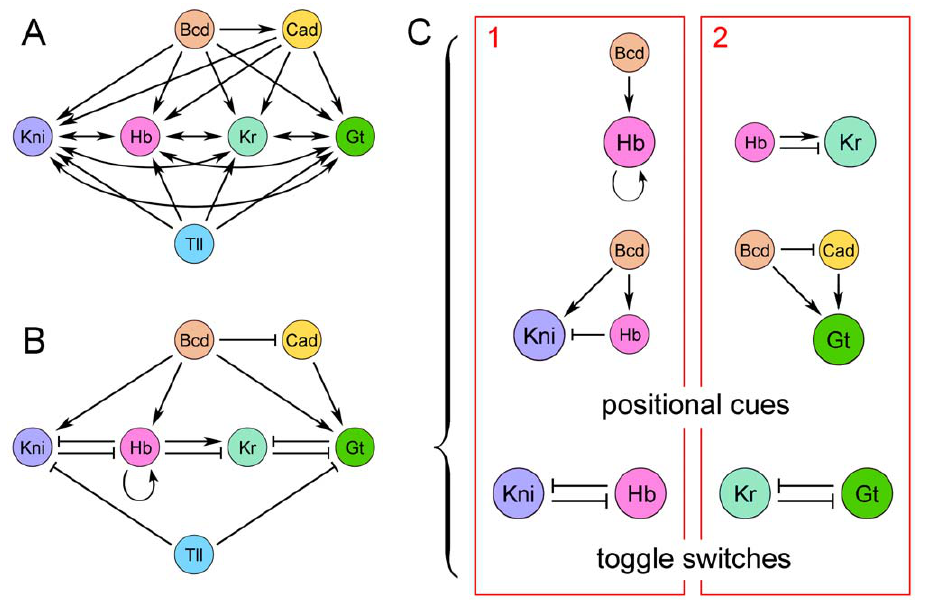
Figure 1. Architecture of the gap gene network. (A) A ‘‘connectionist’’ network starts from total connectivity. Fitting connectionist model to data removes unnecessary links and adds signs (activation or repression). (B) A ‘‘minimalist’’ network, connectivity reflects critical interactions supported by genetic data and connectionist models. (C) Modular design: the minimalist network is split into parallel sub networks (1 and 2, in red), each containing one toggle switch, operated by two positional cues.